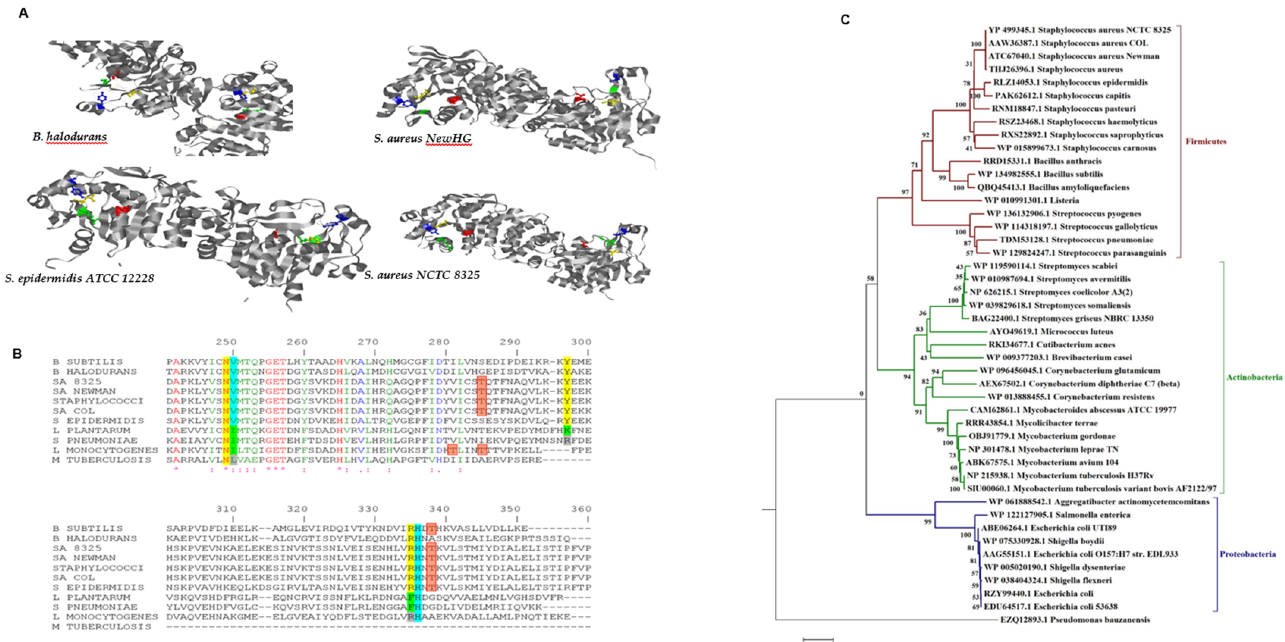
Figure 6. Highly conserved phosphorylation sites in GlmR/Yvck. ( A ) 3D structure analysis of GlmR/YvcK. Crystal structure of B. halodurans GlmR/YvcK (PDB ID: 2O2Z), S. epidermidis ATCC 12228 (PDB ID: 2PPV), S. aureus NewHG and S. aureus 8325. The residues of GlmR/YvcK predicted to interact with UDP-Glc (+/ − NAc) are highlighted. The figure is visualised with RasMOL software. The structures highlight conserved residues in S. aureus shared with B. halodurans . Residues in B. halodurans : Thr13, Asn217, Tyr264 and Arg300. Residues in S. epidermidis ATCC 12228: Thr14, Asn217, Tyr264 and Arg302. Residues conserved in S. aureus NewHG/NCTC 8325: Thr13, Asn216, Tyr263 and Arg301. These residues are predicted to interact with UDP-Glc (+/ − NAc). Colour code: Thr (red), Asn (yellow), Tyr (blue) and Arg (green). We predicted here UDP-GlcNAc-binding residues only. NAD-binding residues are shown in MSA. ( B ) Identification of residues involved in UDP sugar binding. Multiple sequence alignment (MSA) of GlmR/YvcK in different bacteria, including several S. aureus strains. The highly conserved region of the multiple alignment (residues 240–360) is shown in the figure. Conserved residues are given in yellow. The conserved amino acids highlighted in blue are those found to interact with NAD in the crystal structure. Species and strain names are given on the left. Numbering according to [18]. Boxed in red are conserved threonine sites. A conserved threonine (Thr338 in the MSA) is known by experimental data to be phosphorylated in B. subtilis [16] and L. monocytogenes [19] and hence predicted by us to be phosphorylated also in S. aureus (Thr304 in its sequence, Thr338 in the MSA). A high degree of conservation for the first part of the MSA is indicated in the bottom line by red signs: * (perfect), : (very strong) and . (strong). The complete sequence alignment profile is enclosed in Figure S5. ( C ) Phylogenetic tree of glmR (yvcK). The glmR/yvcK evolutionary history is depicted by using the maximum likelihood method. Different bacterial species are given, and the three clades Firmicutes (blue), Actinobacteria (magenta) and Proteobacteria (green) are distinguished on the right. The percentage of trees in which the associated taxa clustered together is shown next to the branches (boot-strapping values through 1000 iterations). The initial tree for the heuristic search was obtained automatically by applying Neighbor-Join and BioNJ algorithms to a matrix of pairwise distances estimated using a JTT model and then selecting the topology with a superior log-likelihood value. The tree is drawn to scale, with branch lengths measured in the number of substitutions per site. There are apparently three clades in the glmR/yvcK